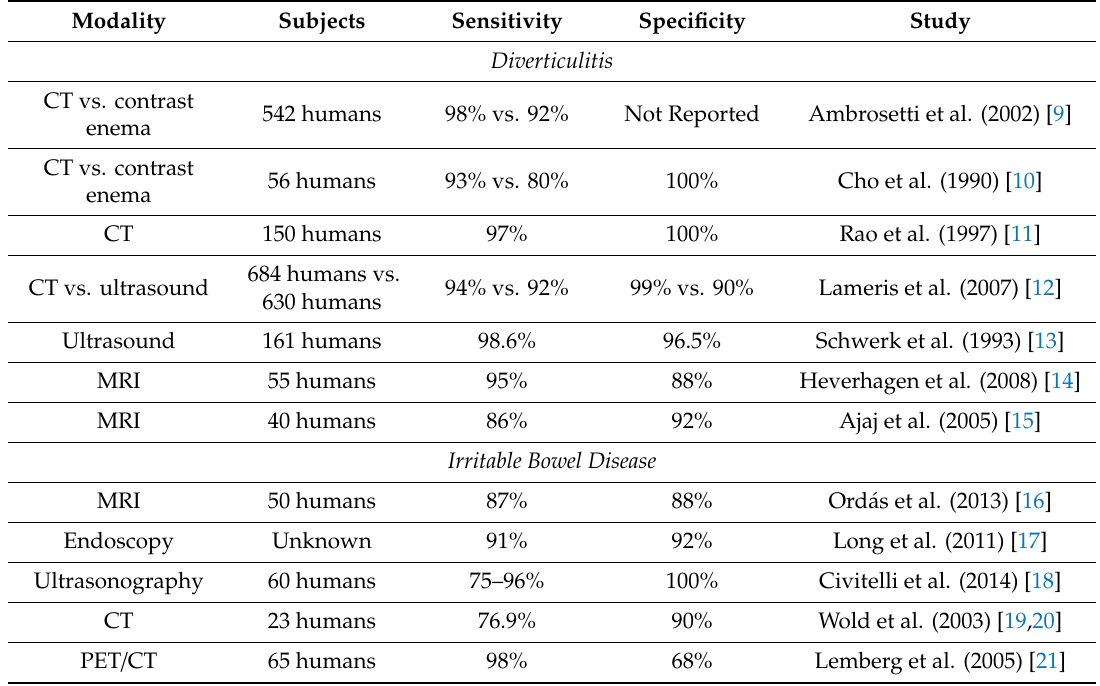
Table 1. Sensitivity and specificity values of di ff erent modalities in reviewed